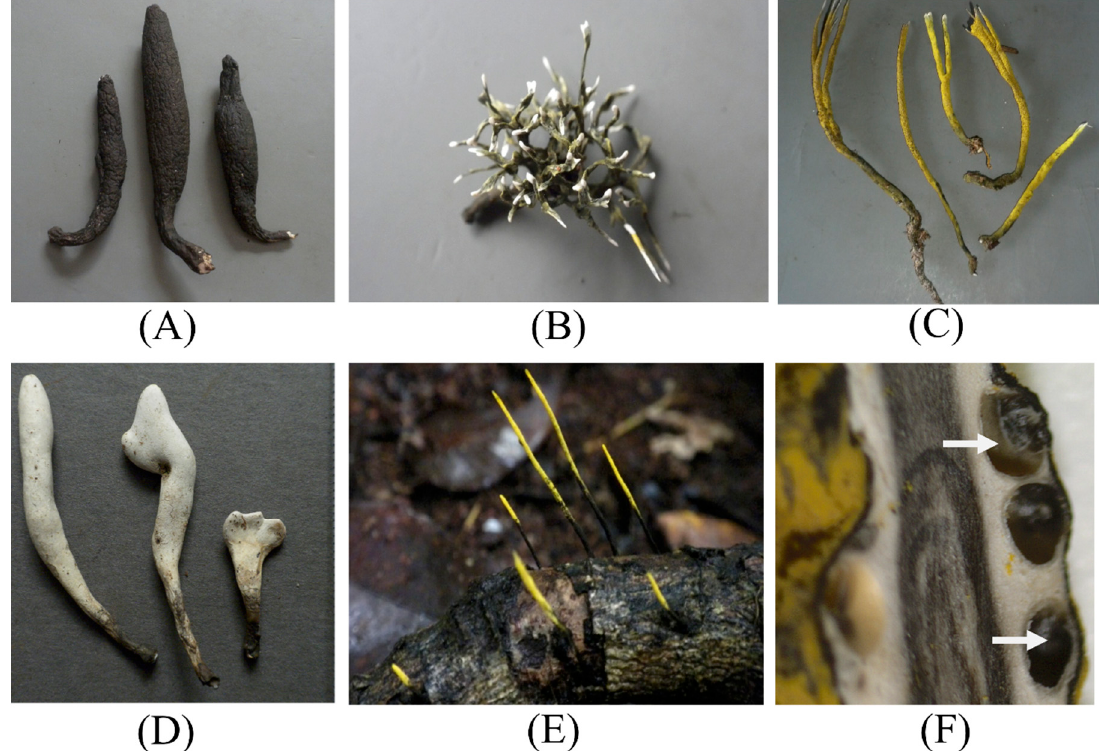
Figure 2. Teleomorphic stromata of various Xylaria species in Guyana. ( A ) Common black carbonaceous morphology of Xylaria sp.; ( B – E ) Other morphologically distinct forms of Xylaria ; ( F ) Section through stromata exposing perithecia (arrows).